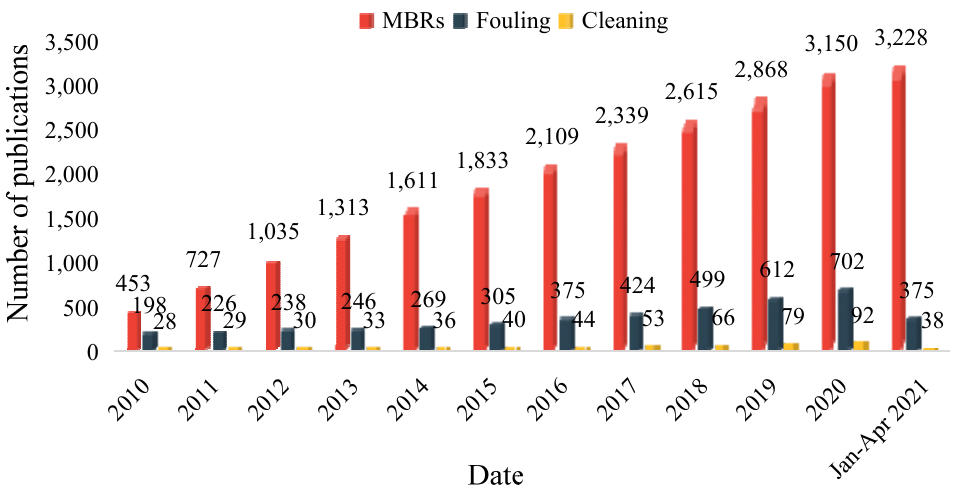
Figure 2. Number of papers published between 2010 and 2021 on MBRs and their fouling and cleaning.